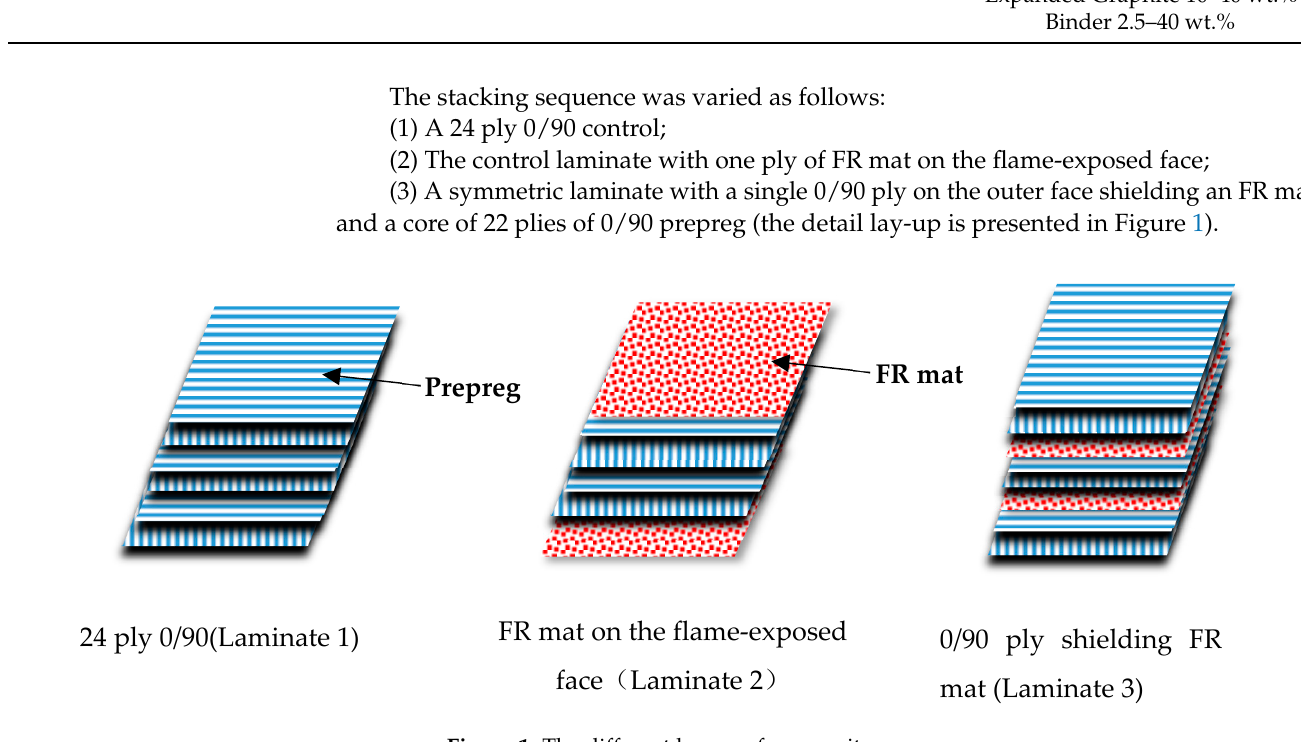
Figure 1. The different lay up of Figure 1 the different lay up of composite.